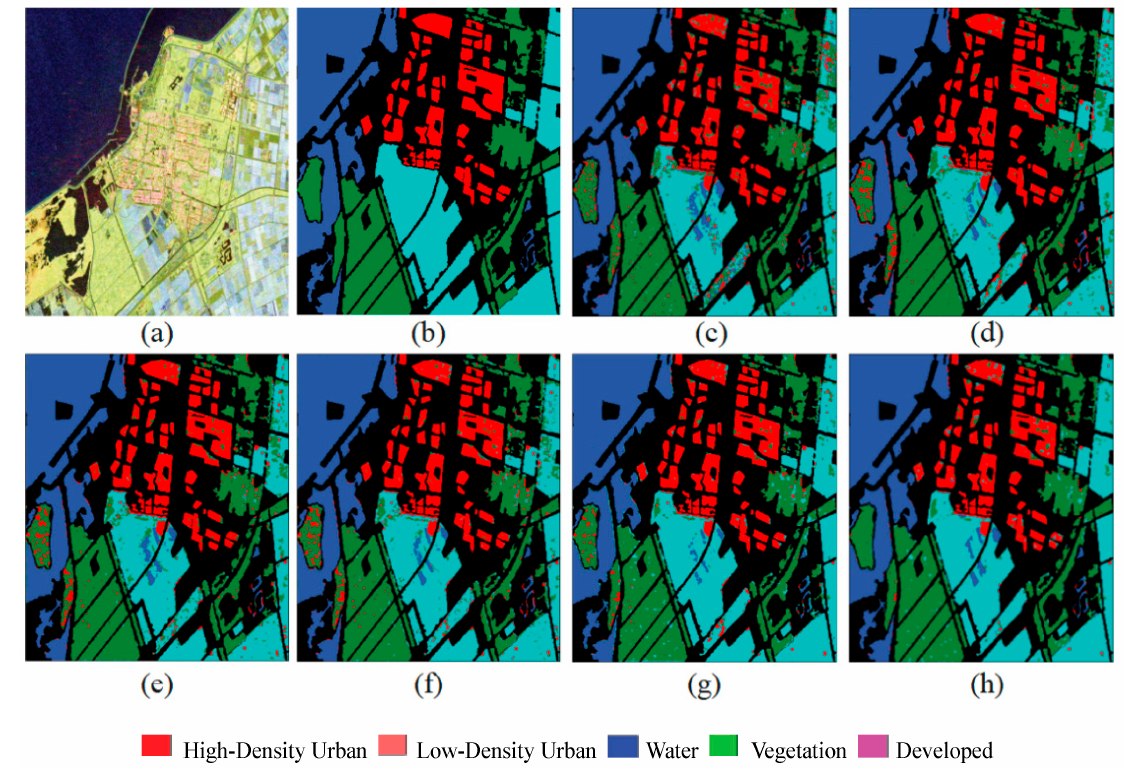
Figure 13. Classification results in the Flevoland II area. ( a ) Pauli image. ( b ) Ground-truth image. ( c ) RN. ( d ) RN-SWANet. ( e ) RRN. ( f ) RRN-SWANet. ( g ) 3D-RRN. ( h ) 3D-ARRN.